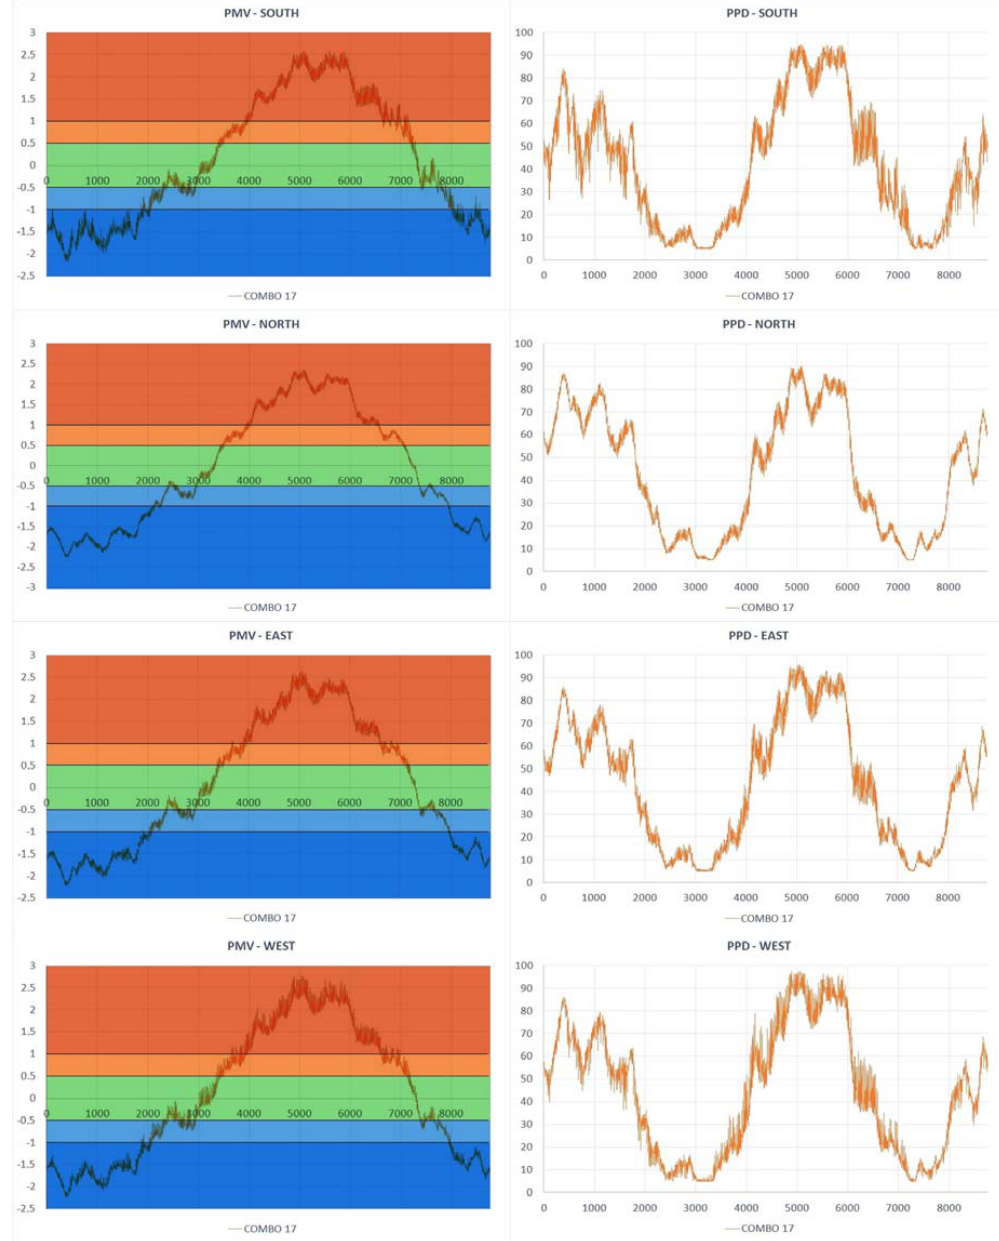
Figure 12. PMV and PPD evaluation for Combo 17.